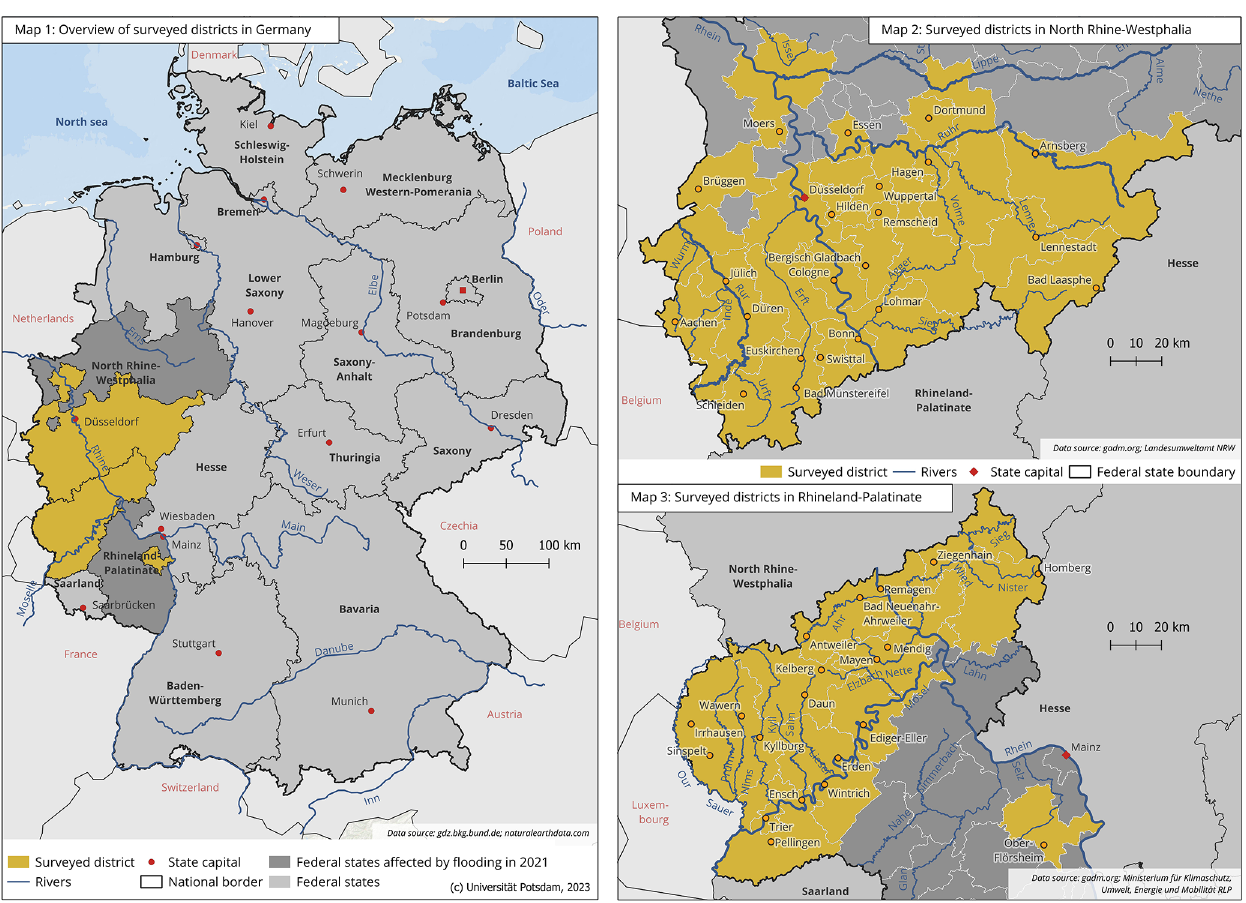
Figure 1. Overview map of Germany (left) highlighting the districts with respondents of the online survey in North Rhine-Westphalia (upper right) and Rhineland-Palatinate (lower